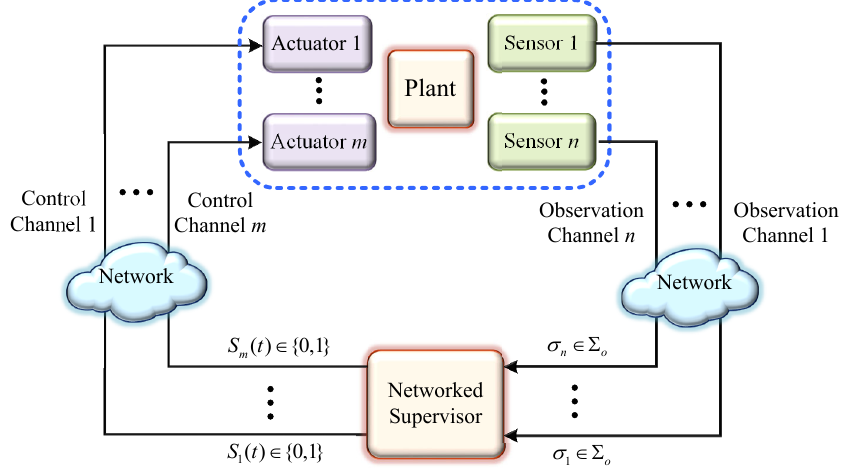
Figure 10. Supervisory control of networked DESs with non-FIFO observations and